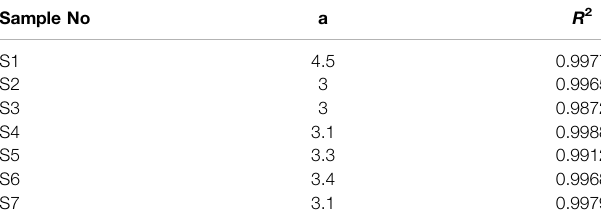
σ d / 3 ) σ d / 3 is similar